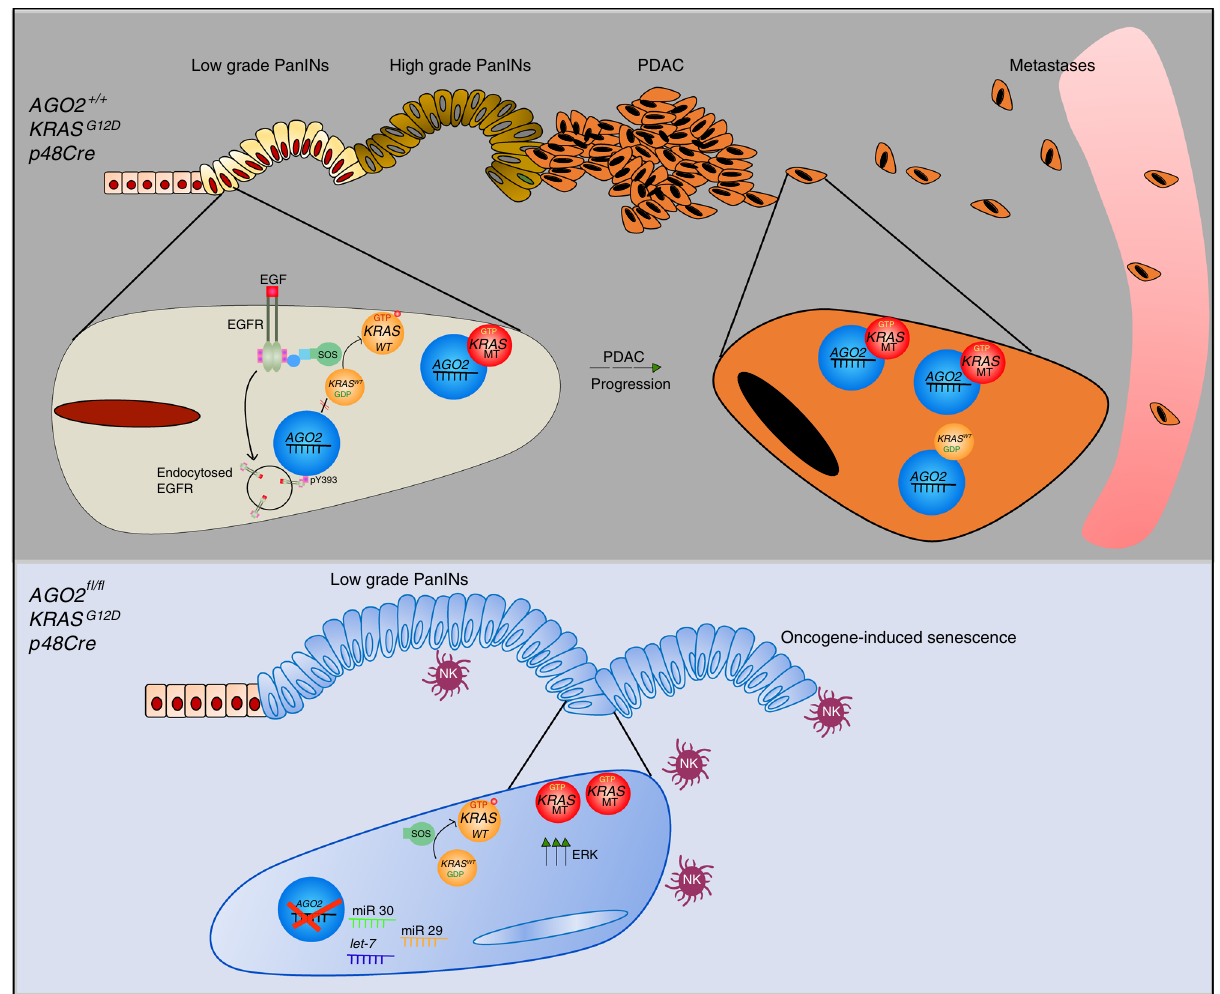
Fig. 9 Schematic model showing the essential role of AGO2 in PDAC progression. Expression of KRAS G12D in normal pancreatic cells initiates low grade PanINs which progress to higher grade PanINs, PDAC, and metastases. PanIN formation requires EGFR that can phosphorylate AGO2 to disrupt the KRAS- AGO2 interaction and is, therefore, AGO2-independent. PDAC progression is associated with increased expression of KRAS and AGO2 at the membrane. AGO2 ablation results in increased expression of microRNAs that regulate cell proliferation and senescence and also activates KRAS to promote oncogene- induced senescence. OIS due to AGO2 loss prevents progression of low grade PanINs to PDAC and leads to in fi ltration by natural killer (NK)